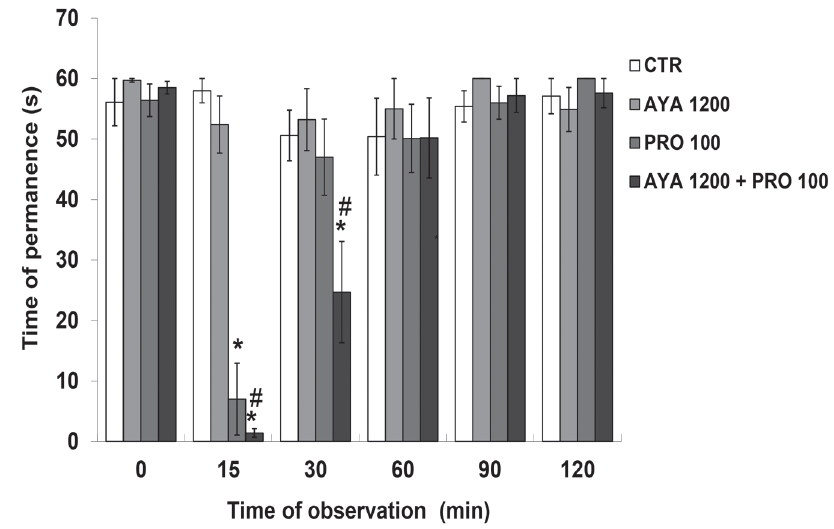
from control; (#) p <0.05: statistically different from AYA 1200. Kruskal-Wallis followed by Mann-Whitney.